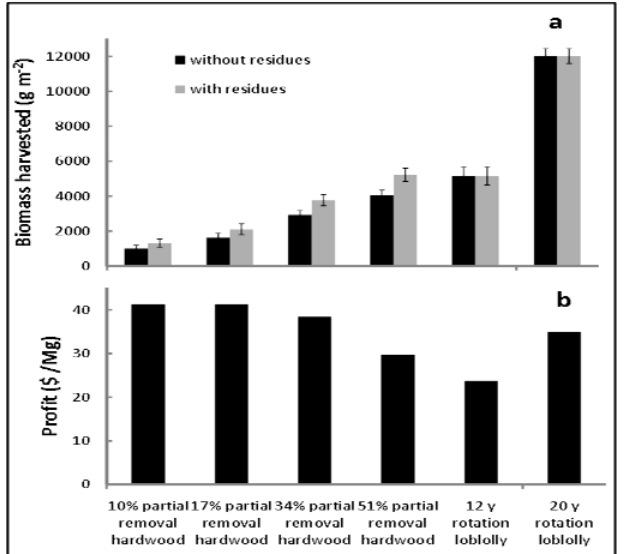
Figure 7. Mean biomass harvested with different managements ( a ) and estimated profit per Mg biomass with an assumed selling price of $50 Mg − 1 , ( b ) in different forest management